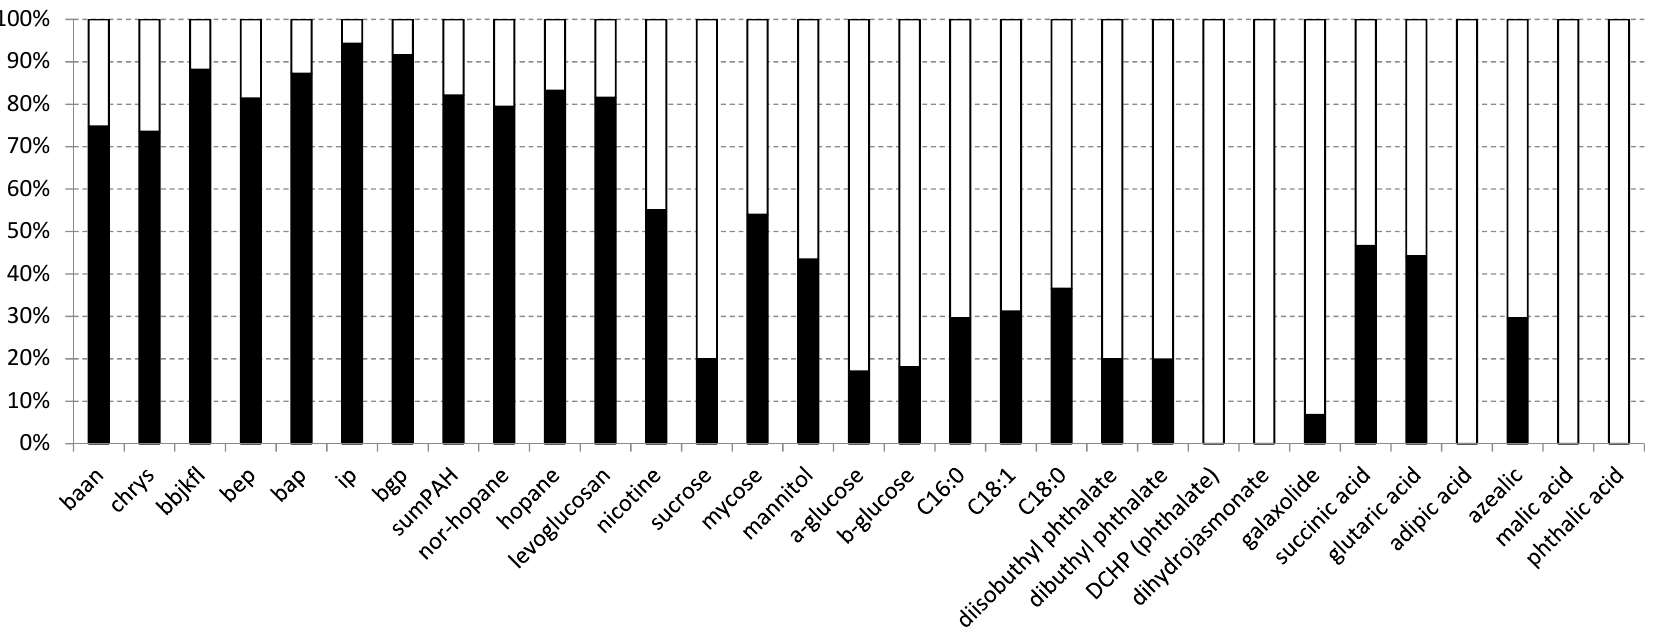
Figure 3. Relative component loadings (%) obtained from multivariate curve resolution-alternating least squares of the organic molecular tracer compounds in PM 2.5 aerosols from the schools shown in Figure 1 that represent the indoor (white bars) and outdoor (black bars) organic aerosol (OA). The abbreviations in the abscissas axis are indicated in Table 1.